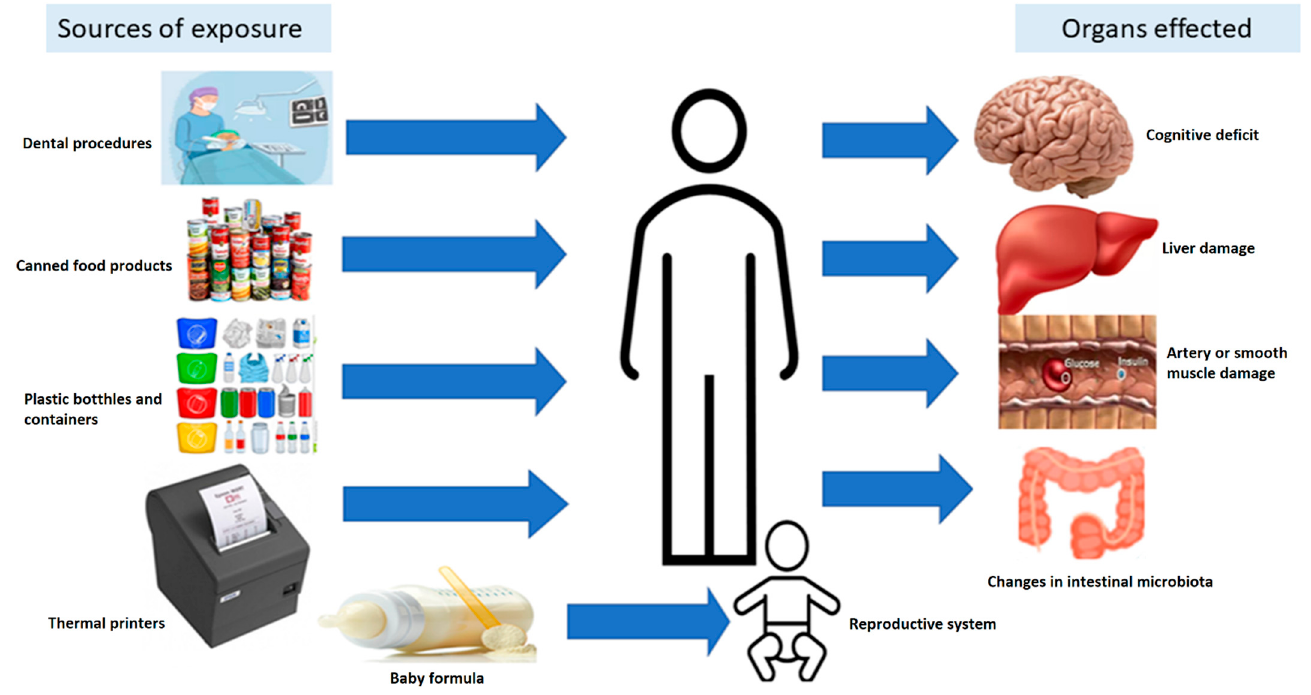
Figure 1. Schematic represention of the sources of BPA exposure and its impact on some of the organs in humans.